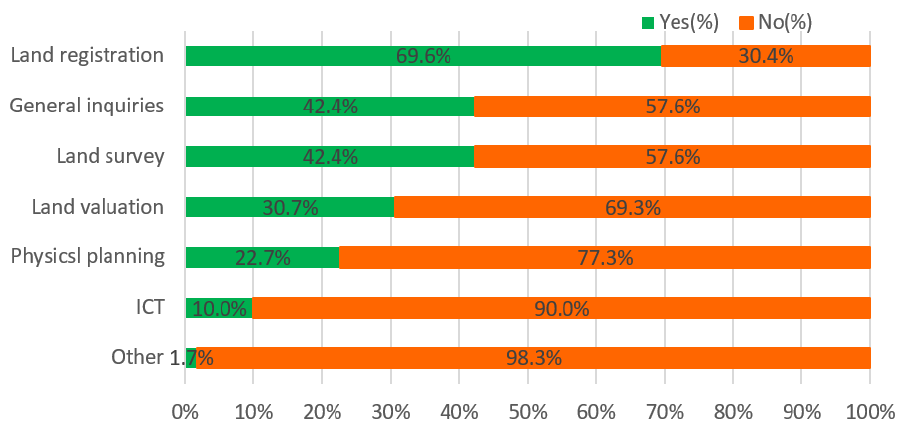
Figure 8. Ardhisasa platform service interactions.